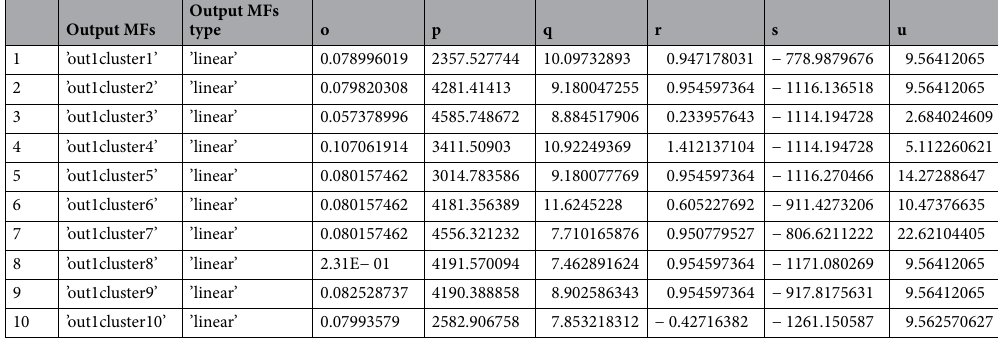
Table 4. GAFIS method consequent parameters for predicting